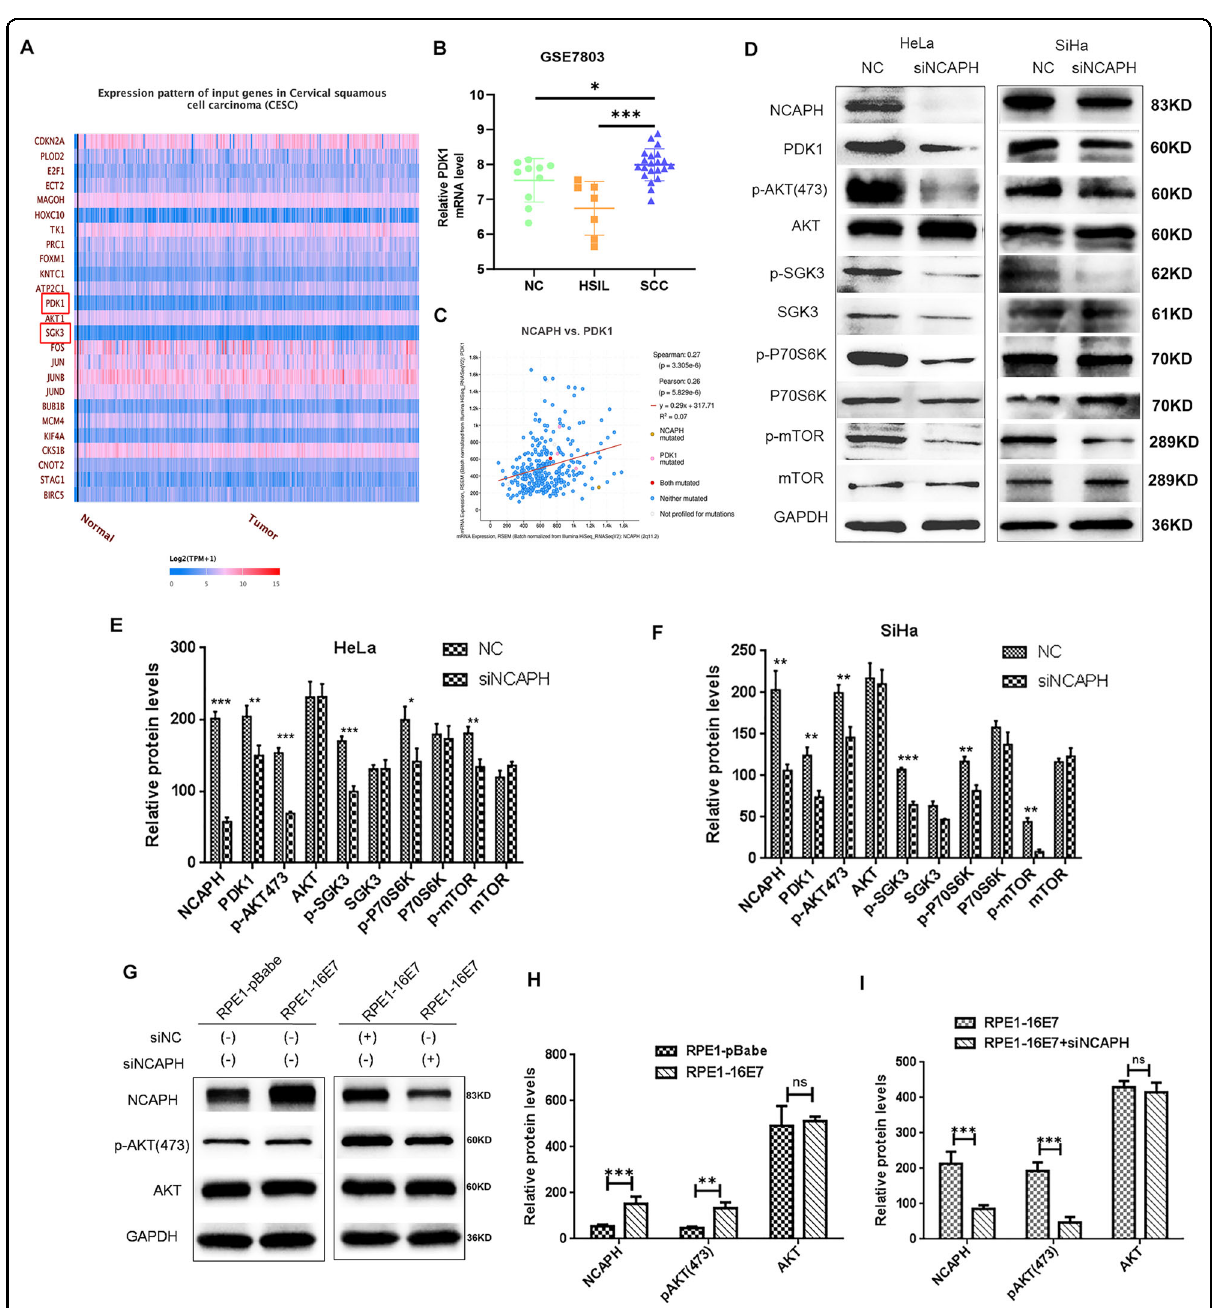
Fig. 7 The involvement of E7 and NCAPH in the regulation of PI3K/AKT/SGK signaling pathway. A The UALCAN database showed that PDK1 was over-expressed in cervical cancer (tumor) compared with normal cervix (normal). B Analysis of GEO database (GSE7803) showed the NCAPH expression in normal cervix (NC), high-grade squamous intraepithelial lesion (HSIL) and cervical squamous cell cancer (SCC). C The cBioportal database revealed the co-expression of NCAPH and PDK1 in cervical cancer. D – F Western blot analysis showed the changes in the levels of key molecules of PI3K/AKT/SGK pathway after the knockdown of NCAPH expression in HeLa and SiHa cells. The relative protein level was analyzed. G – I Western blot analysis showed the protein levels of NCAPH, p-AKT(Ser473) and total AKT in RPE1-pBabe or RPE1-16E7 cells with or without transfection. The relative protein level was analyzed. NC, negative control siRNA; siNCAPH, siRNA targeting NCAPH gene. Data are presented as mean ± SD ( n = 3). * represents p < 0.05, ** represents p < 0.01, *** represents p < 0.001, ns not signi fi